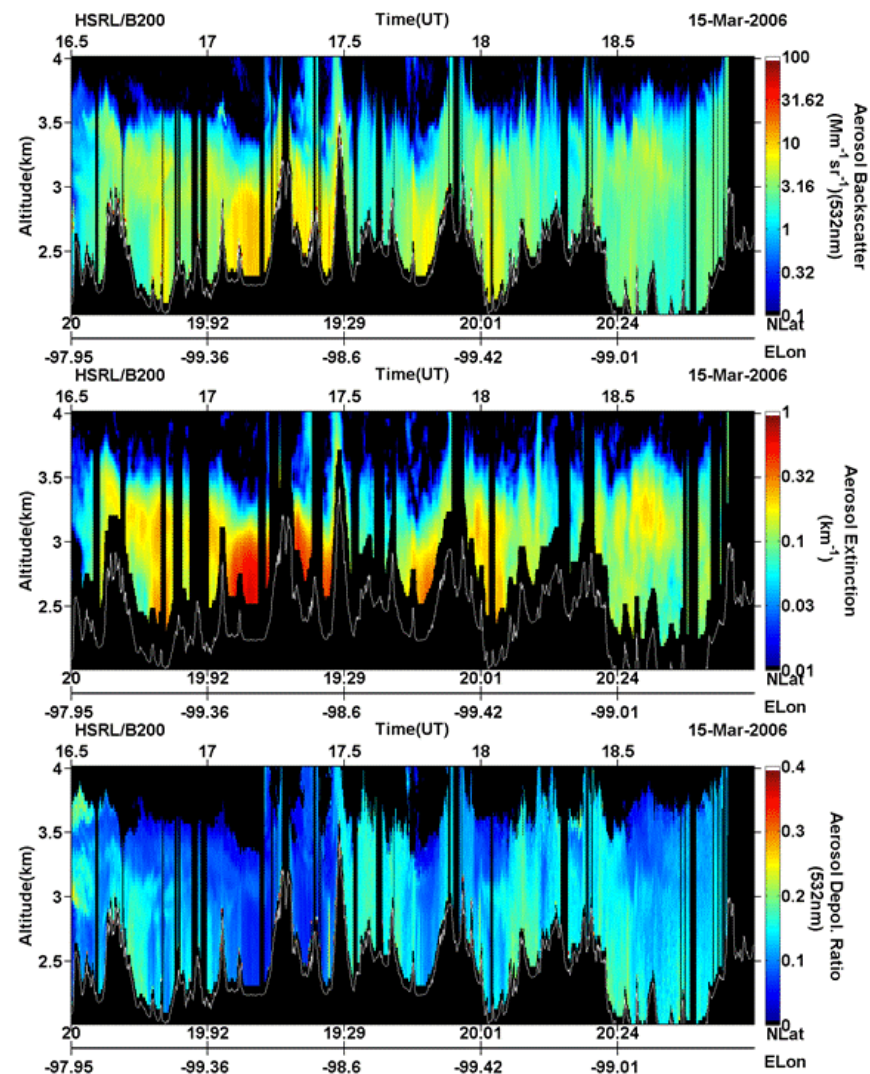
Fig. 2. HSRL-1 measurements of the aerosol backscattering coefficient at 532nm (top), the aerosol extinction coefficient at 532nm (middle) and the aerosol depolarization ratio, δ , at 532nm (bottom) are shown for a flight over Mexico City and surrounding regions on 15 March 2006 during the MILAGRO campaign. Black vertical lines indicate no data, usually due to shuttering the laser during aircraft turns or filtering data that is attenuated by